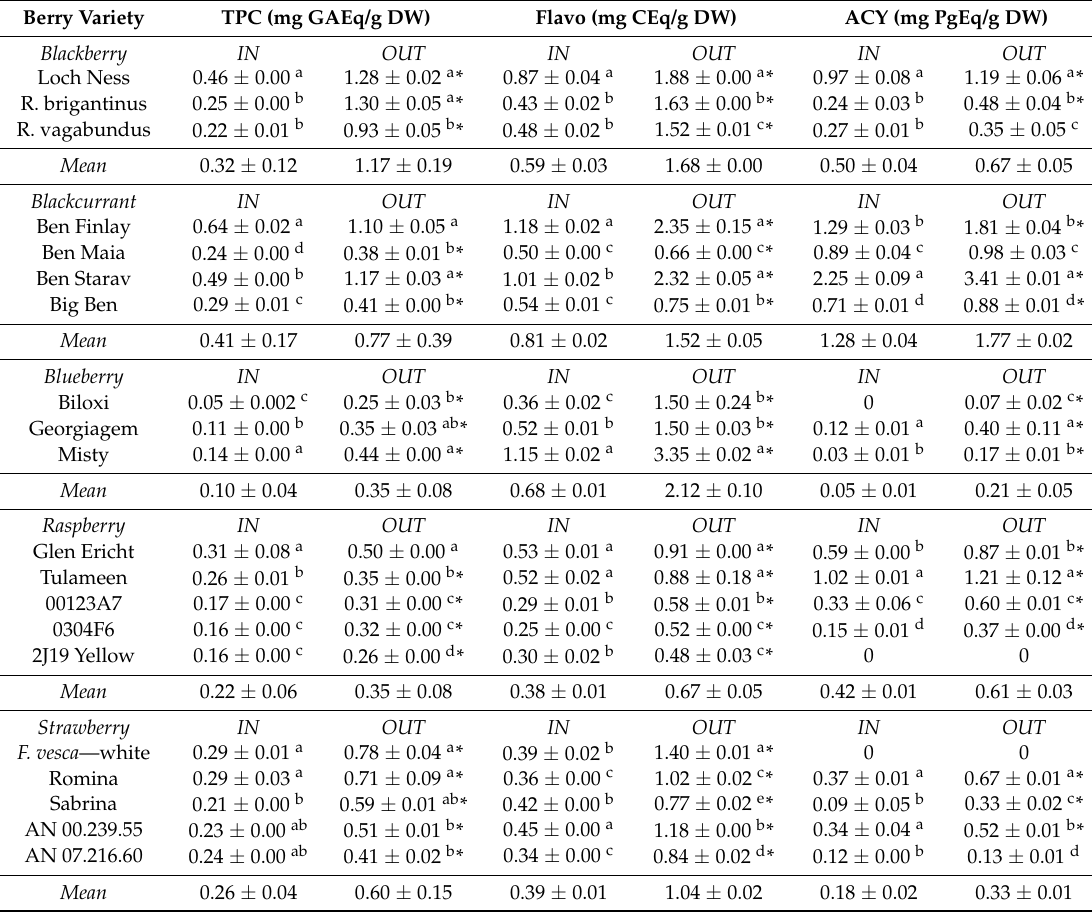
Table 1. Phytochemical composition of the “IN” and “OUT” samples from different berries following the in vitro